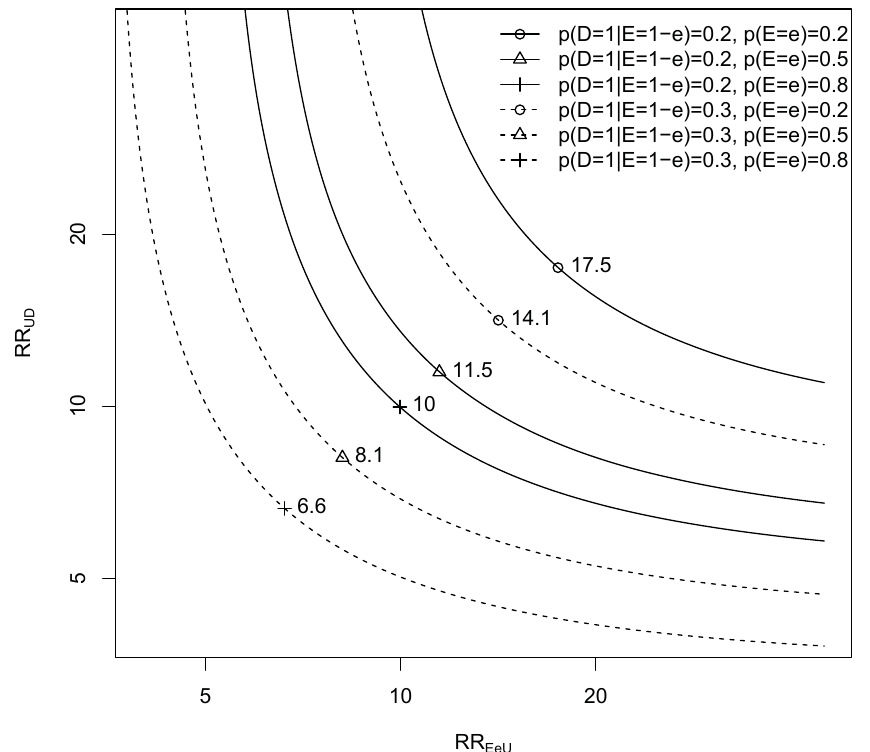
Figure 1: Regions of { RR EeU , RR UD } for which the assumption-free bounds are sharper than DV’s bounds, for selected values of p ( D = 1 | E = 1 − e ) and p ( E = e ) . The figure applies to the lower bounds when e = 1 , and to the upper bounds when e = 0 . Both axes use logarithmic